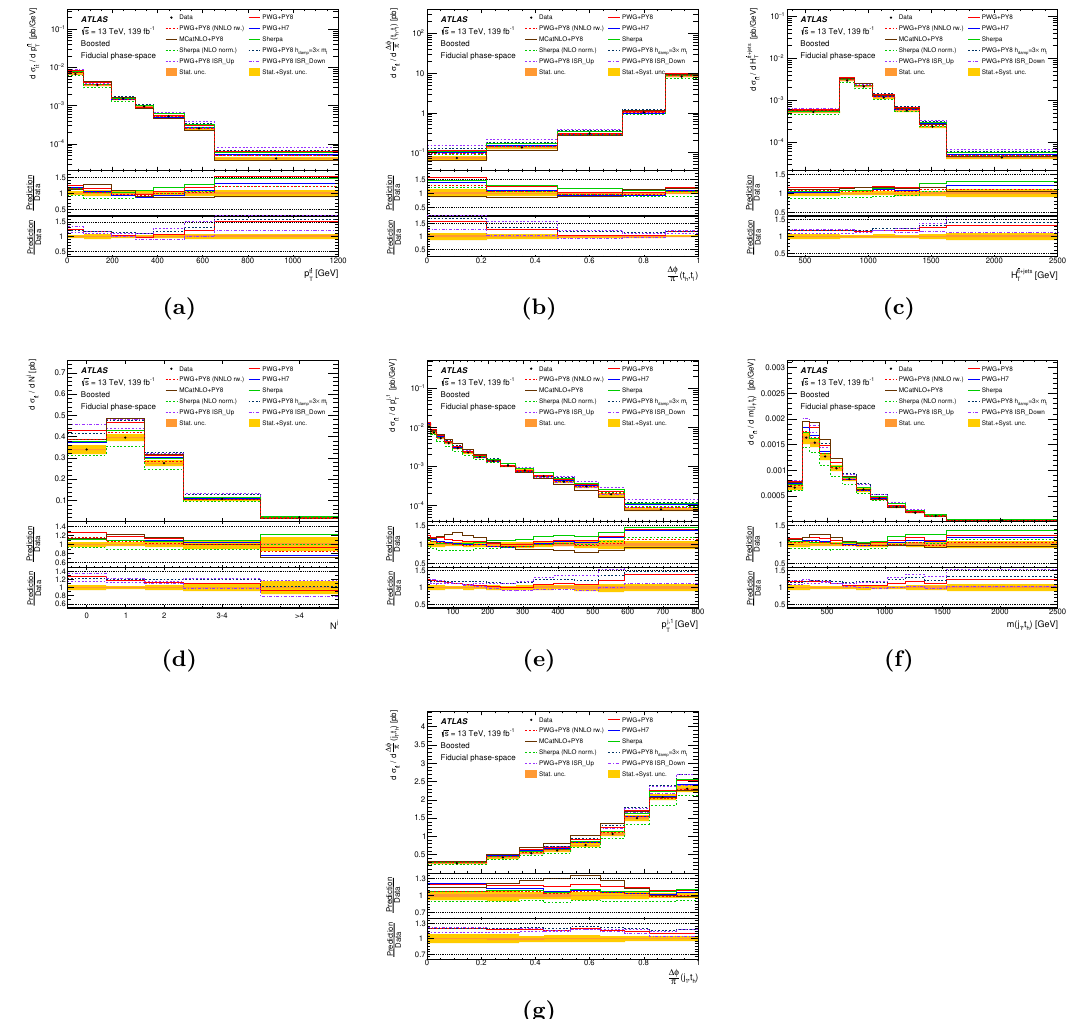
Figure 12. Differential cross-section measurements for the observables related to jets pro- duced in association with the t ¯ t system. The cross-section is shown as a function of (a) p t ¯ t , T (b) ∆ φ ( t ) , (c) H t ¯ t +jets , (d) N j , (e) p j, 1 , (f) m ( j ) and (g) ∆ φ ( j ) . In each plot the , t , t , t h ‘ 1 h 1 h T T data are compared with predictions from various MC generators. PWG+PY8 corresponds to the Powheg+Pythia sample, PWG+H7 to the Powheg+Herwig sample and MCatNLO+PY8 to the MadGraph5_aMC@NLO+Pythia sample. The orange band shows the size of the statisti- cal uncertainty and the yellow band shows the size of the total uncertainty. The lower two panels in each subfigure display the ratios of the different predictions to the